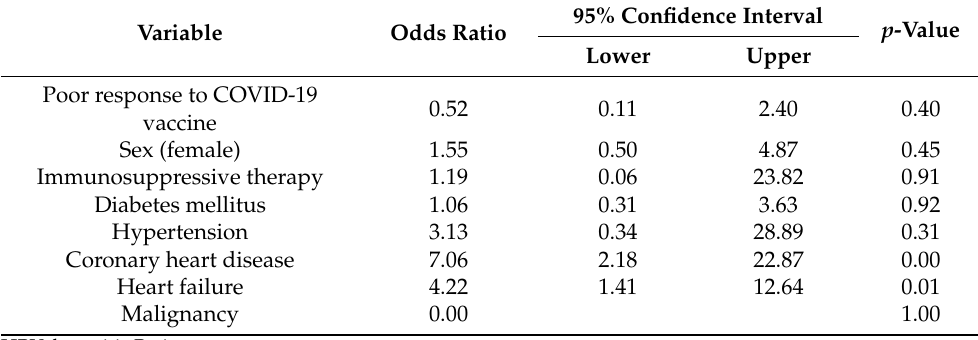
Table 3. Multivariate regression analysis for predictors for no response to HBV vaccine. Variable Odds